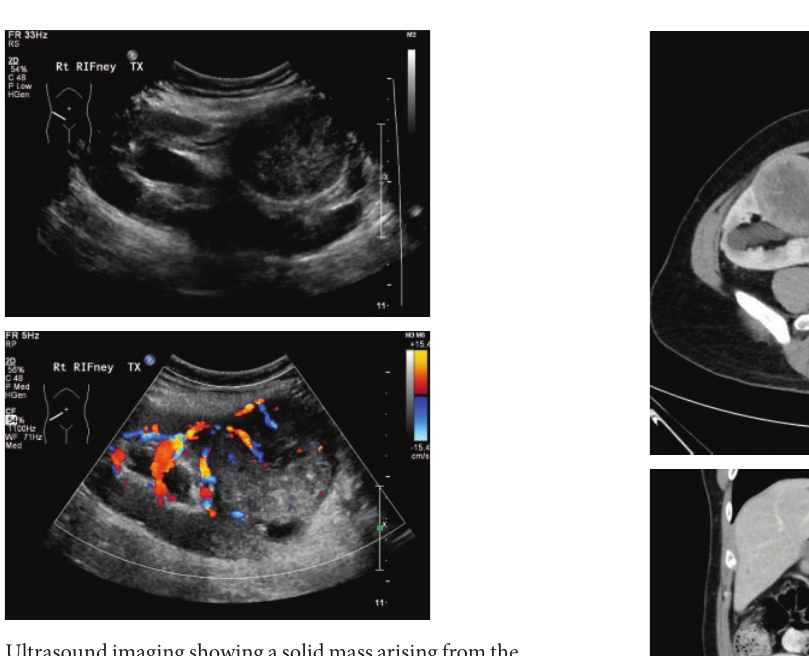
Figure 1: Ultrasound imaging showing a solid mass arising from the midpole of the renal allograft with internal vascularity.